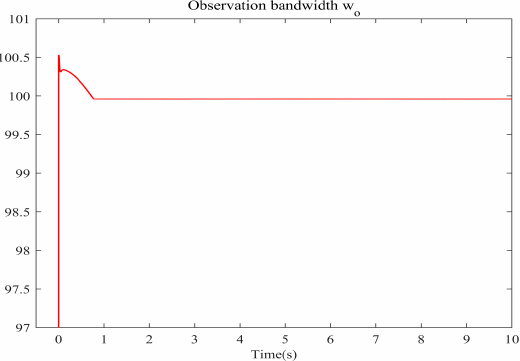
w in the inverted pendulum sys-